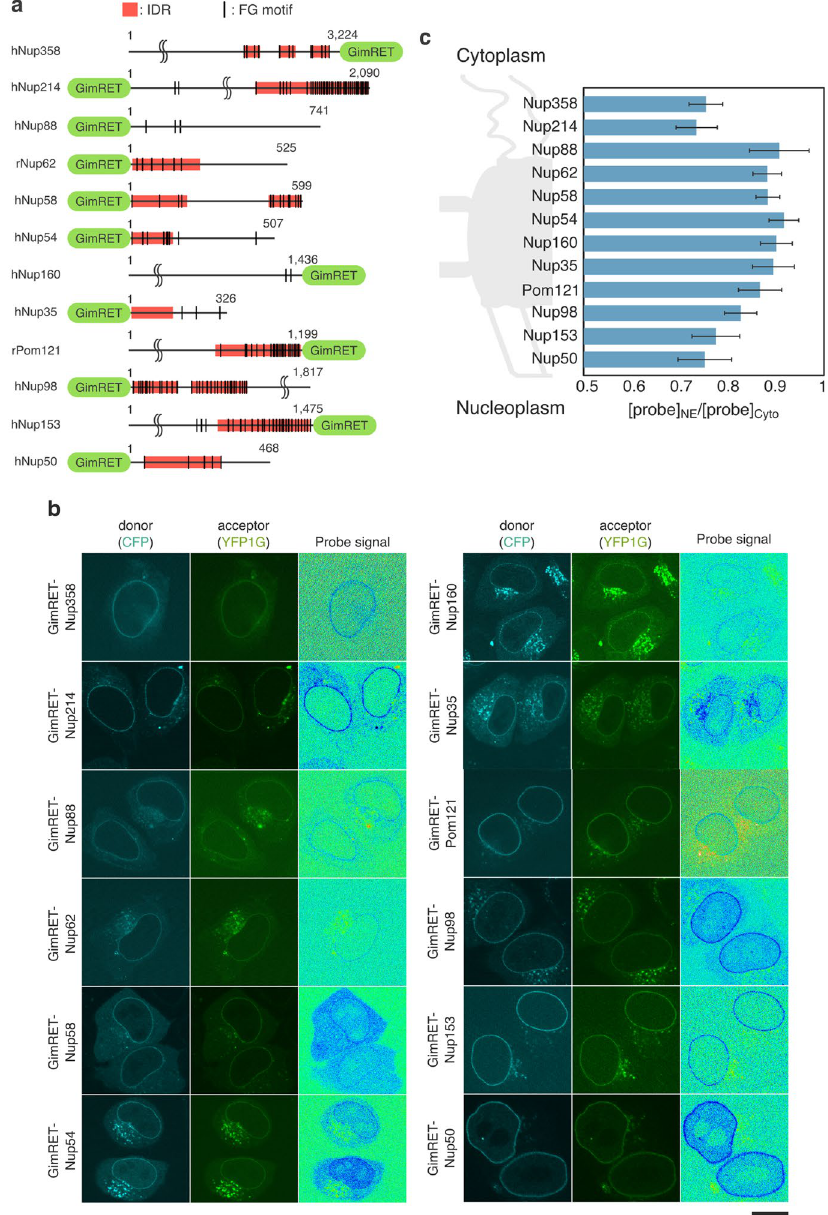
Figure 2. The NPC contains two protein-rich domains in both peripheries. ( a ) Schematic representation of GimRET-fused Nups used in this study. Intrinsically disordered regions (IDRs) are predicted by PONDR algorithm and shown with red bar. FG-motif is indicated with a vertical line. The position of the GimRET probe is also depicted at either end of the polypeptide. UniProtKB accession numbers used for sequence prediction: P49792, hNup358; P35658, hNup214; Q99567, hNup88; P17955, rNup62; Q9BVL2, hNup58; Q7Z3B4, hNup54; Q12769, hNup160; Q8NFH5, hNup35; P52591, rPom121; P52948, hNup98; P49790, hNup153; Q9UKX7, hNup50. ( b ) Fluorescence imaging of HeLa cells expressing GimRET-fused Nups. The sample was excited by 435 nm, and the donor (CFP, 460–500 nm, left), and acceptor (YFP1G, 520–570 nm, middle) images were captured. The ratio (acceptor/donor) image is also shown (right). Scale bar: 20 μ m. ( c ) A summary of probe signals from 12 different GimRET-fused Nups. The probe signal (acceptor/donor) at the nuclear envelope ([probe] NE ) was measured in individual cells and presented as a relative value to that in the cytoplasm ([probe] Cyto ) (also see Figure S3d). This means that protein crowding in each part of the NPC was evaluated as a relative value to that in the cytoplasm. Data are aligned from top to bottom according to the approximate localization along the pore axis from the cytoplasmic to the nucleoplasmic ends as previously described 19 . Data are presented as mean ± SD from more than 20 different cells. Some Nups showed some punctae, which represented crowding (Fig. 2, Nup214 and Nup35). These crowded punctae can be considered the artifacts by the overexpression because GimRET-fused another type of target proteins related to cytoplasmic aggregates showed similar crowding (data not